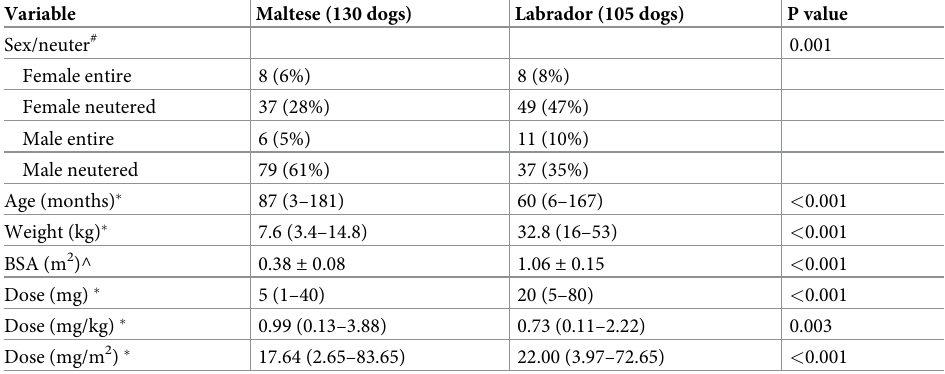
Table 8. Comparison of Maltese and Labrador dogs treated with prednisolone for inflammatory skin